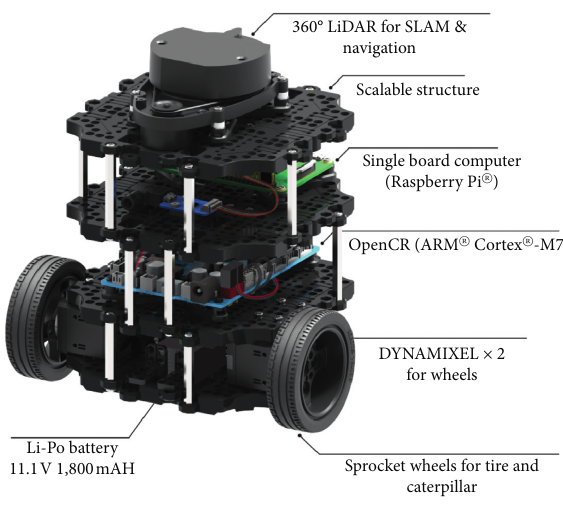
Figure 7: TurtleBot3 mobile robot. Table 1: Hardware specifications of TurtleBot3 mobile robots.